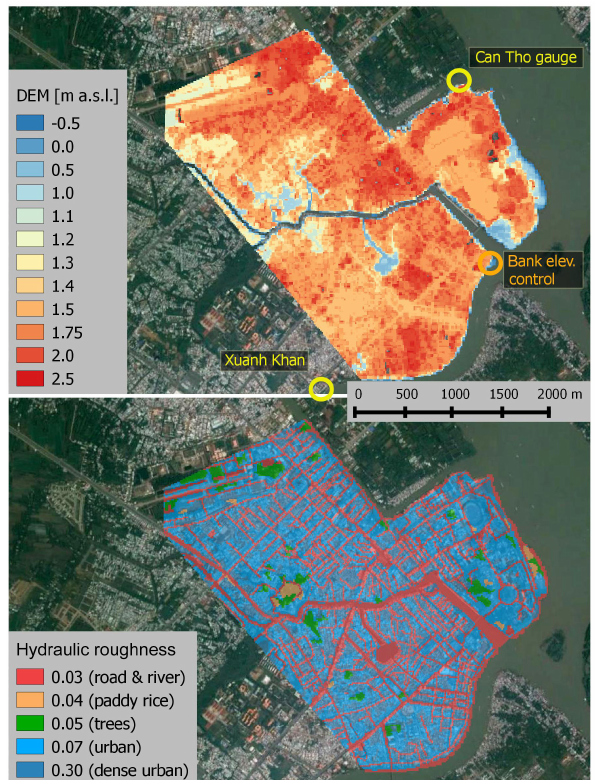
Figure 2. Top panel: central part of Can Tho city with DEM over- lay. The yellow circles indicate gauge locations, the orange circle the location of the river bank, where Takagi et al. (2015) measured water levels which were used for correcting the datum of the DEM. Bottom panel: central part of Can Tho with hydraulic roughness map (Manning’s n values) derived from land use